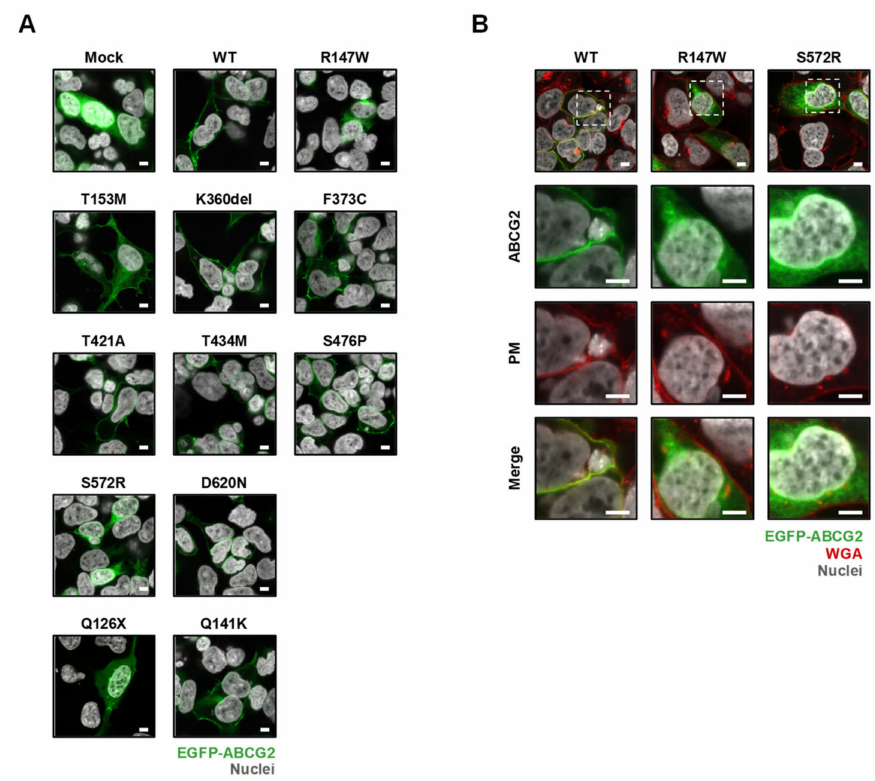
Figure 4. E ff ects of each mutation on the cellular localization of ABCG2 protein in transiently transfected 293A cells. ( A ) Intracellular localization of ABCG2 variants. Q126X (a stop gain variant that is deficient in the plasma membrane localization [22]) and Q141K are controls. ( B ) High magnification images of cells transfected with R147W and S572R variants indicate that these mutations impaired localization to the plasma membrane of the cells. Framed areas in the panels of top lane were observed under a higher magnification. Confocal microscopic images were obtained 48 h after the transfection. Nuclei were stained with TO-PRO-3 iodide (gray). Plasma membrane (PM) was labeled with Alexa Fluor ® 594-conjugated wheat germ agglutinin (WGA) (red). Bars indicate 5 µ